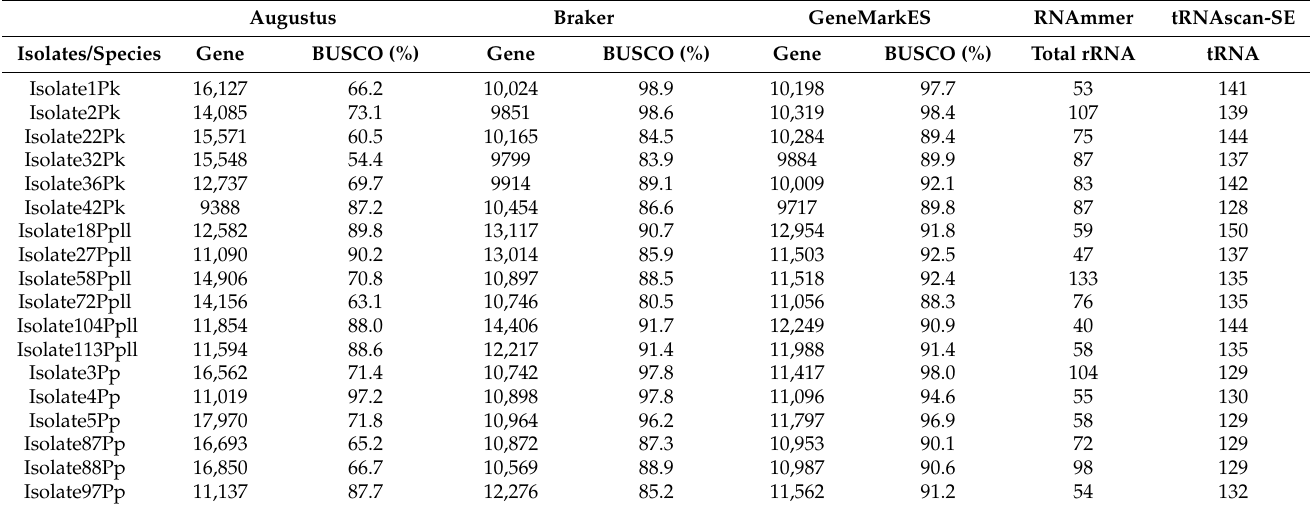
Table 2. Genome annotation—statistics on the number of genes identified and the BUSCO